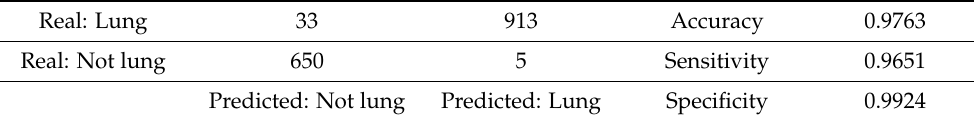
Table 5. Results for VGG16-2000 applied to the testing data. Real: Lung 33